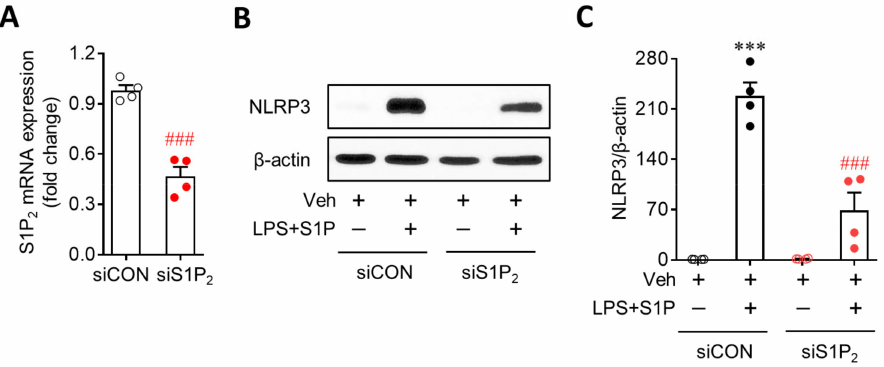
Figure 3. S1P 2 knockdown attenuates S1P-induced NLRP3 upregulation in LPS-primed BMDMs. BMDMs transfected with non-target control siRNA (siCON) or S1P 2 -specific siRNA (siS1P 2 ) were primed with LPS (500 ng/mL) for 4 h and exposed to S1P (1 µ M) for 1 h. ( A ) S1P 2 knockdown efficiency by its specific siRNA was determined by qRT-PCR analysis. n = 4 per group. ### p < 0.001 versus control siRNA (siCON)-transfected BMDMs. ( B , C ) Effects of S1P 2 knockdown on NLRP3 up- regulation were analyzed by Western blot. Representative blots of NLRP3 ( B ) and quantification ( C ). n = 4 per group. *** p < 0.001 versus control BMDMs transfected with control siRNA (siCON + Veh). ### p < 0.001 versus LPS/S1P-treated BMDMs transfected with control siRNA (siCON + LPS +